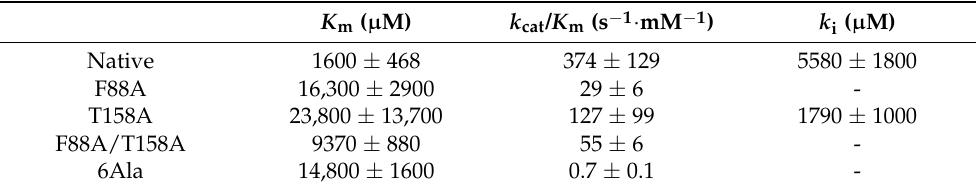
Table 1. Kinetic constants for H 2 O 2 reaction with native r Cvi UPO and